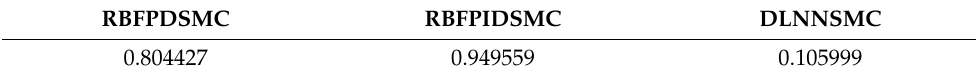
Table 4. Average values of D E .